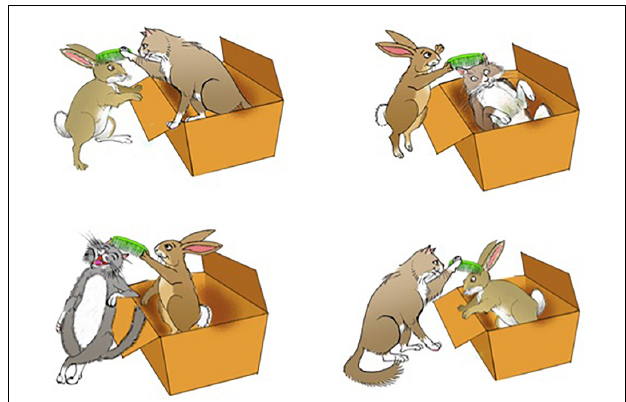
FIGURE 1 | Example pictures for one trial of the experimental task. Permission to use this picture was granted by Prof. Maria Teresa Guasti, University of Milan Bicocca.